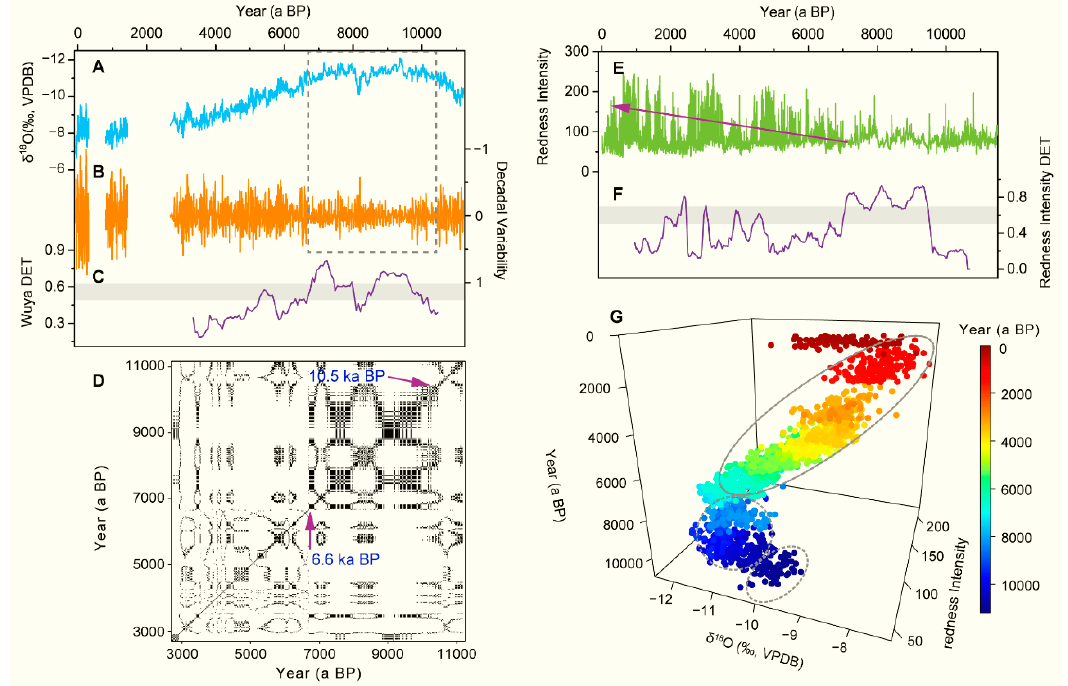
Figure 1. Stalagmite δ 18 O record from Wuya cave in China and ENSO record from South American coast during the Holocene. ( A ) ASM variations indicated by Wuya δ 18 O record [6], ( B ) Decadal scale variability of the Wuya δ 18 O record decomposed by EEMD method [6]. The dotted box marks the strongest ASM period during the Holocene with less decadal variability. ( C ) DET measurement for the Wuya δ 18 O record, ( D ) RP results for Wuya δ 18 O record. The arrows indicate two regime transitions occurred at ~6.6 ka BP and 10.5 ka BP. ( E ) ENSO variations recorded by the red color intensity of lake sediment from South American coast [7], ( F ) DET measure for the red color intensity. Two gray bars in panels C and F denote 95% confidence levels. ( G ) Scatterplot of the Wuya δ 18 O record [6] versus the red color intensity [7].